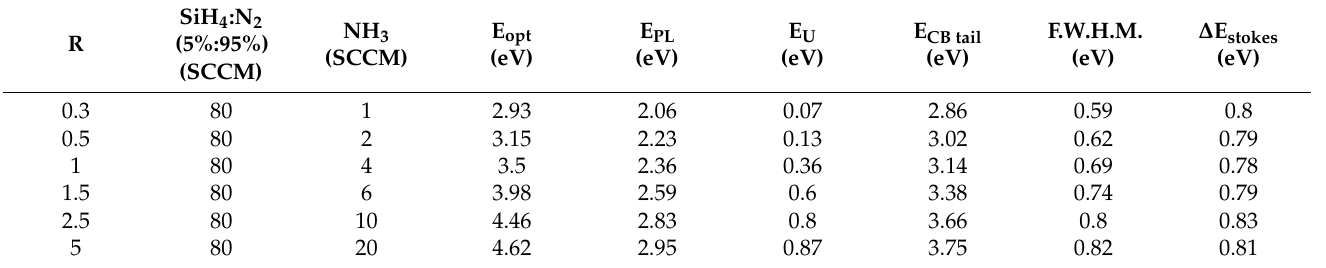
Table 1. Summary of the fabrication parameters, E opt , E PL , E U , E CB tail , F.W.H.M., and ∆ E stokes of a-SiN x O y systems at room